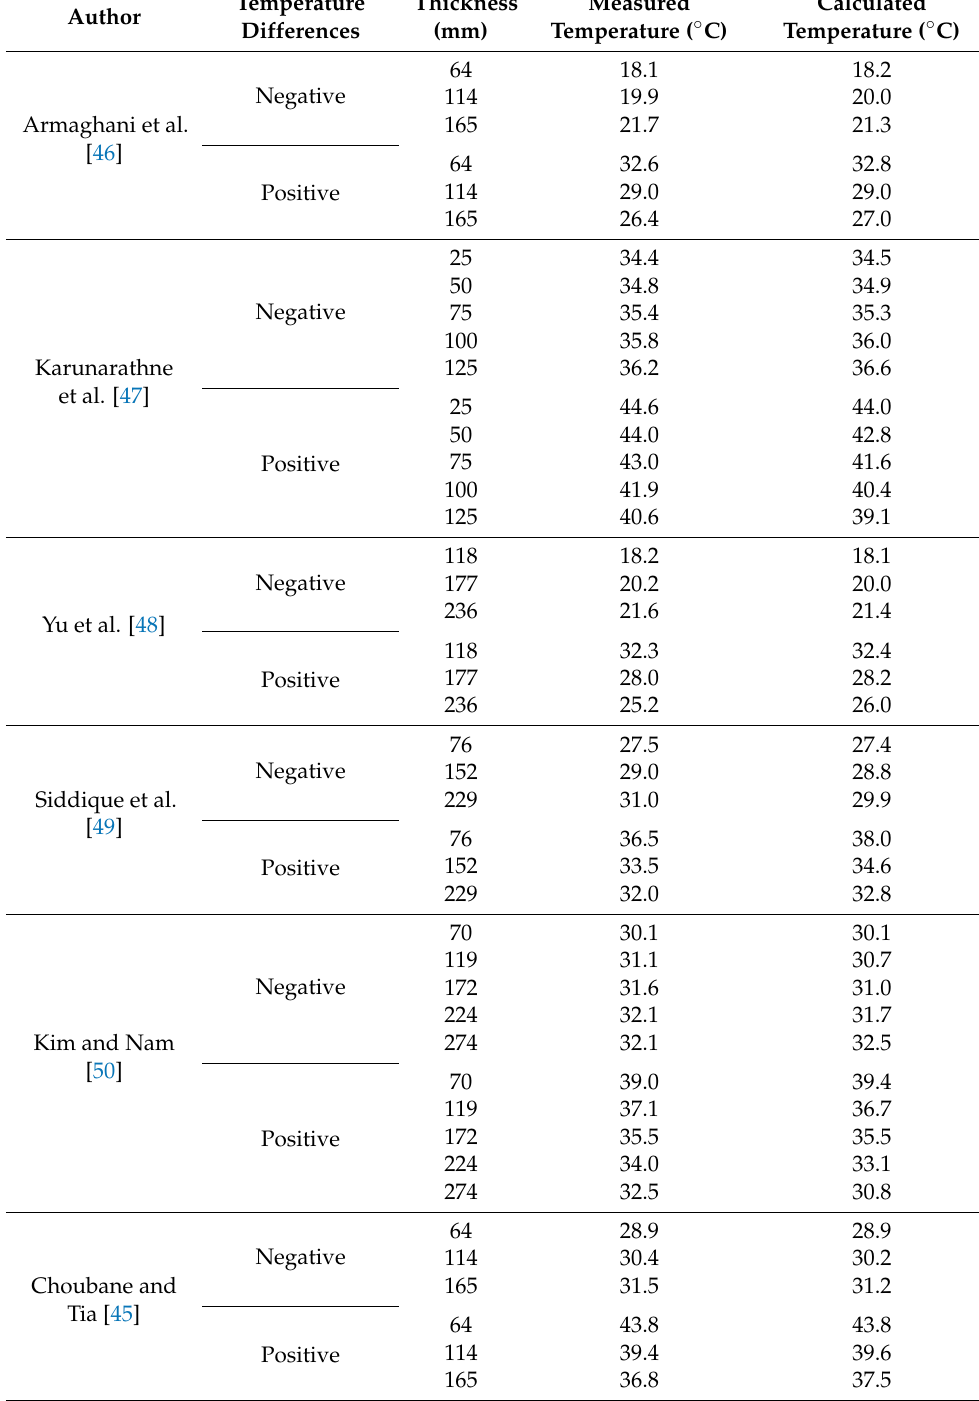
Table 7. Comparing the temperatures measured along with the depth of the pavement with the temperatures calculated on a bilinear